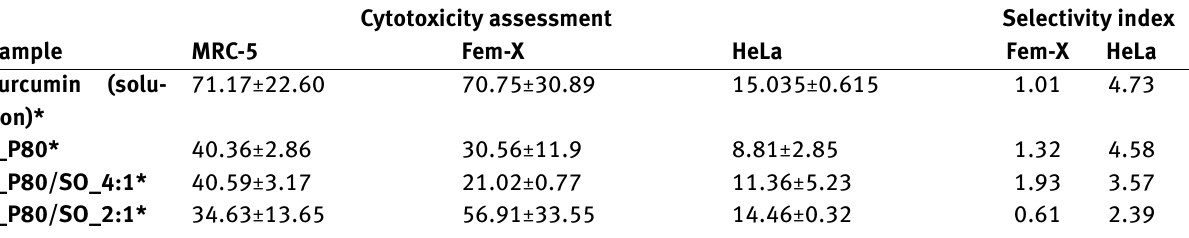
Table 4: MTT assay results (concentrations of curcumin (dissolved) and curcumin nanocrystals expressed in µ g/ml that induced 50% decrease in the cell survival (IC50)) and calculated selectivity index of curcumin in a solution and curcumin nanocrystals